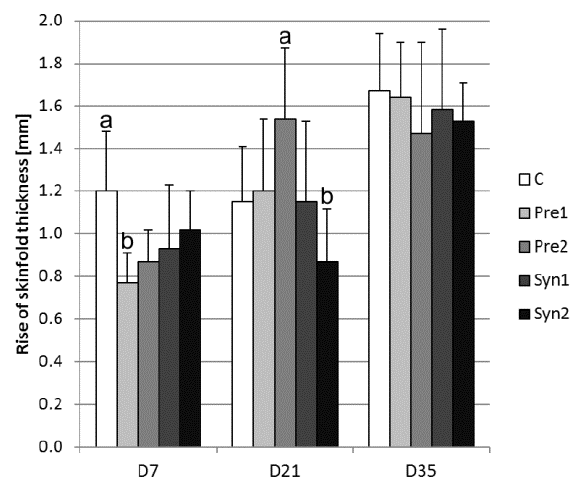
Figure 5. Delayed-type hypersensitivity (DTH) measured as an increase in skin fold thickness 24 h after an intradermal injection of phytohemagglutinin (mean ± SD): C – control, Pre1 – prebiotic 1, Pre2 – prebiotic 2, Syn1 – synbiotic 1, and Syn2 – synbiotic 2. Significant difference a,b; * p < 0.05 within time groups.